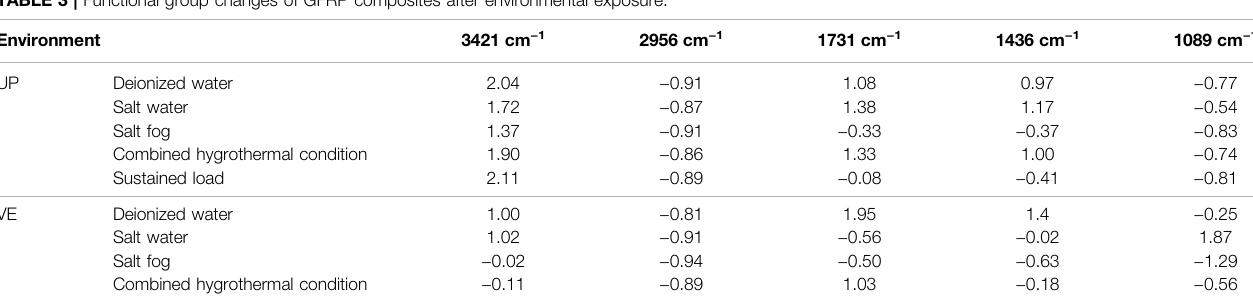
TABLE 3 | Functional group changes of GFRP composites after environmental exposure.